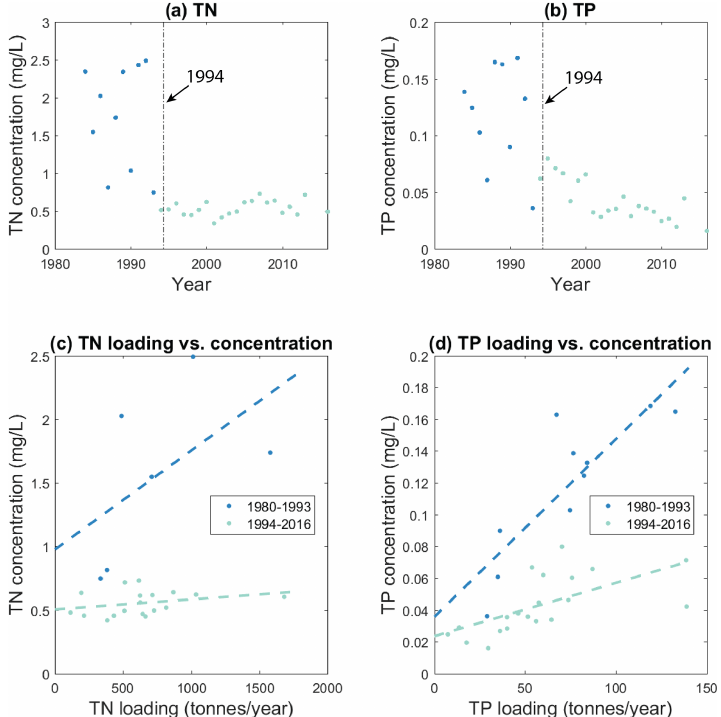
Figure 15. Changes in the mean nutrient concentration of (a) total nitrogen (TN) and (b) total phosphorus (TP) in the Peel–Harvey Estuary (based on the average of the six main monitoring stations) and their relationship with the total annual nutrient loading (c, d)